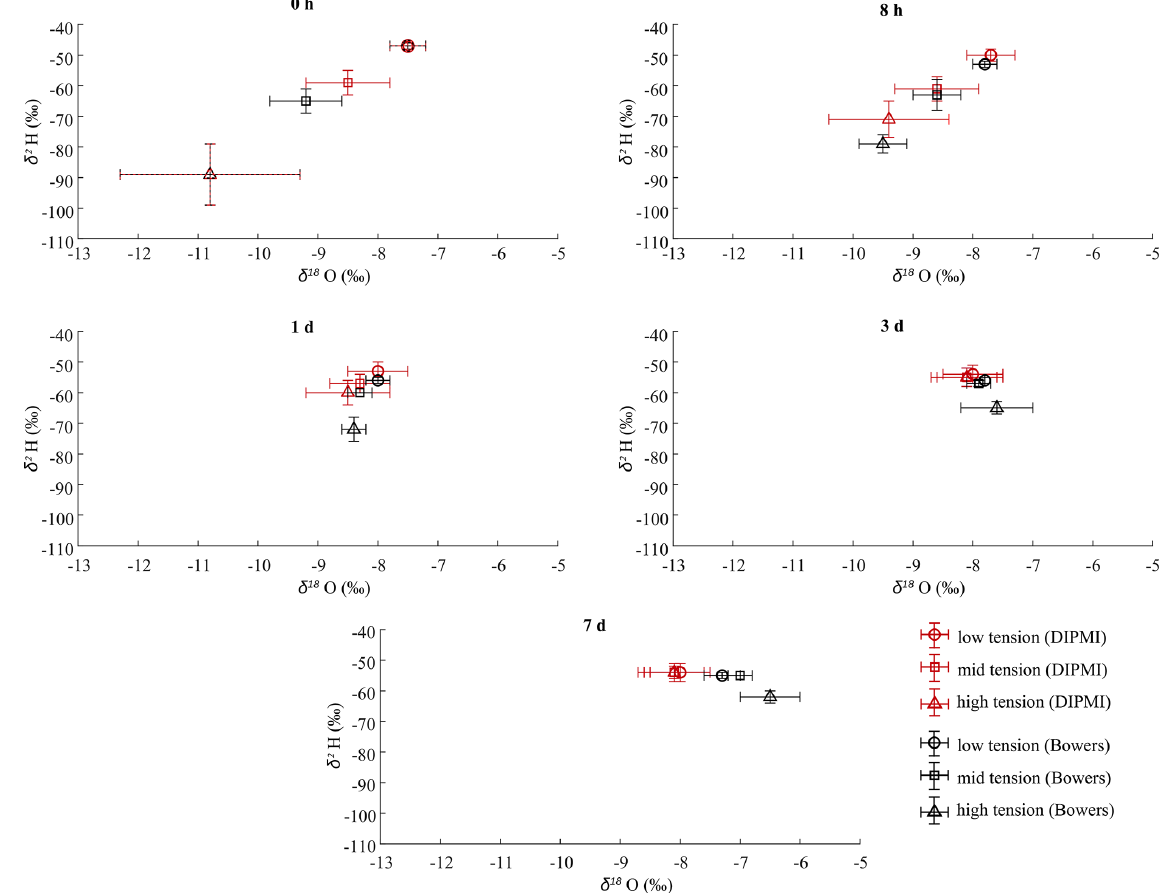
Figure 2. Isotopic concentrations in a dual-isotope space for each tension area and time point, simulated (red) by the DIPMI approach with pore-size-distributed D values and measured (black) by Bowers et al. (2020). Note that, at t = 0h, the simulated and measured isotopic values in the low-tension and high-tension areas are